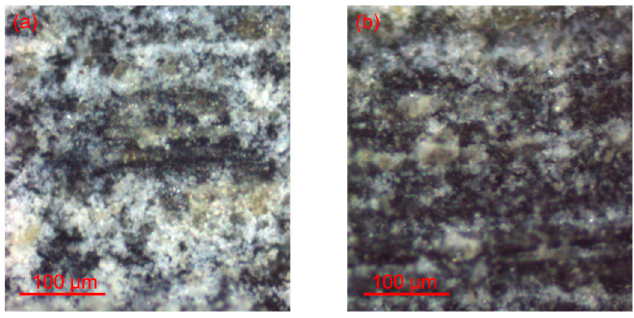
Figure 7. Optical microscopy images of ( a ) ALG150; ( b ) ALG150ITA (10× magnification).